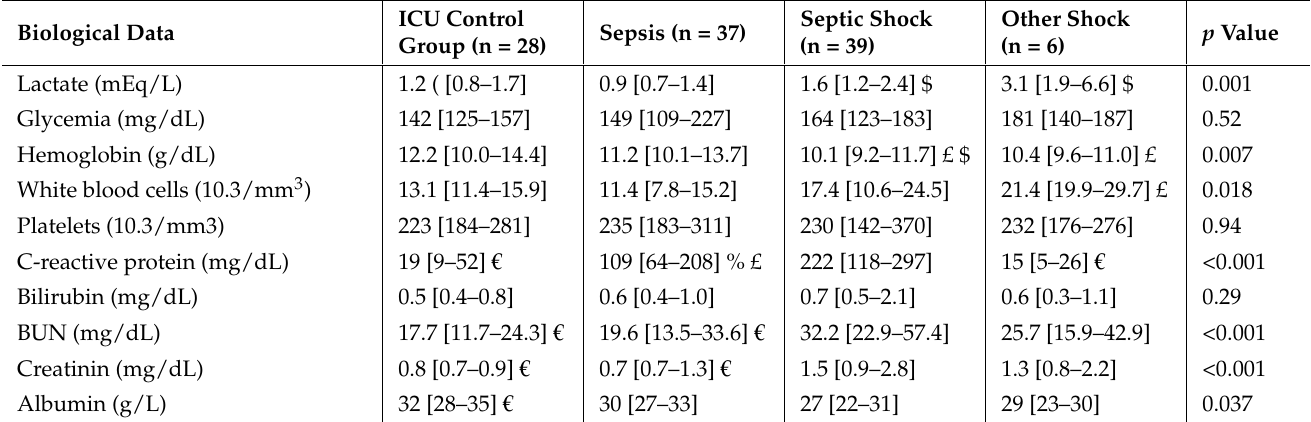
Table 3. Biological data in the different patient groups.